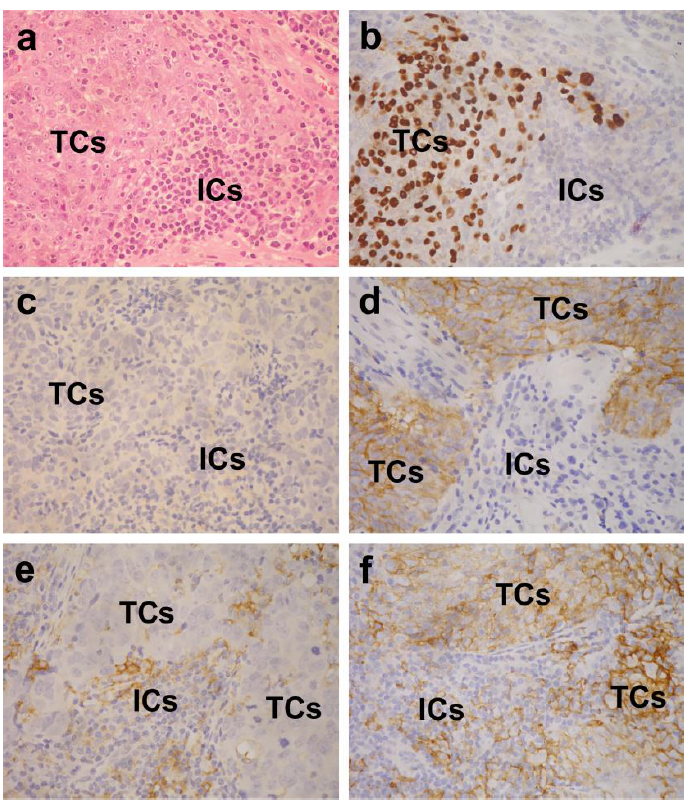
Figure 6. Epstein-Barr virus (EBV)-positive nasopharyngeal carcinoma (NPC) is characterized by poorly differentiated tumor cells (TCs) and many admixed immune cells (ICs) ( a ; H&E